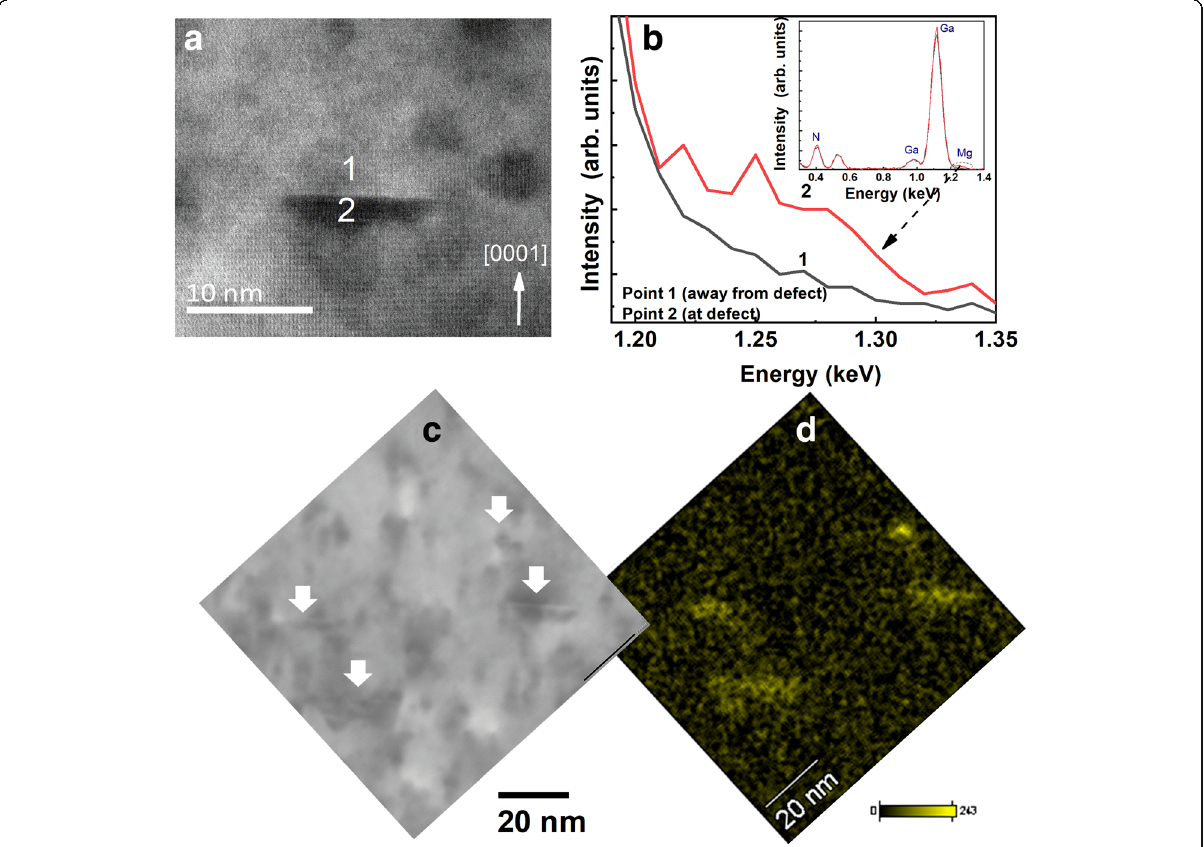
Fig. 4 a Cross-sectional STEM image of Mg implanted GaN sample showing an individual type “ B ” defect. Points 1 and 2 represents regions where EDS measurements are carried out and resulting EDS spectra are shown in b . EDS spectra in the energy range of 1.19 – 1.40 keV is plotted in b with inset showing the full EDS spectra with Ga and N peaks. c and d present STEM image and corresponding Mg map of a similar